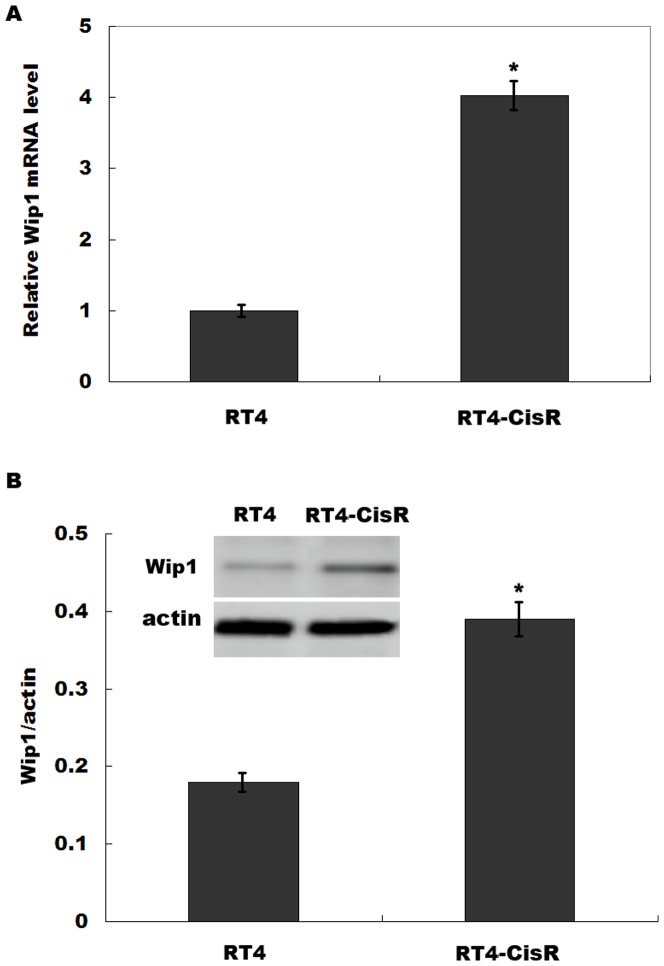
Wip1 expression is upregulated in RT4-CisR cell compared with RT4 cell.(A and B) Wip1 mRNA and protein expression levels were assayed in RT4 and RT4-CisR cells, respectively. *p<0.05.